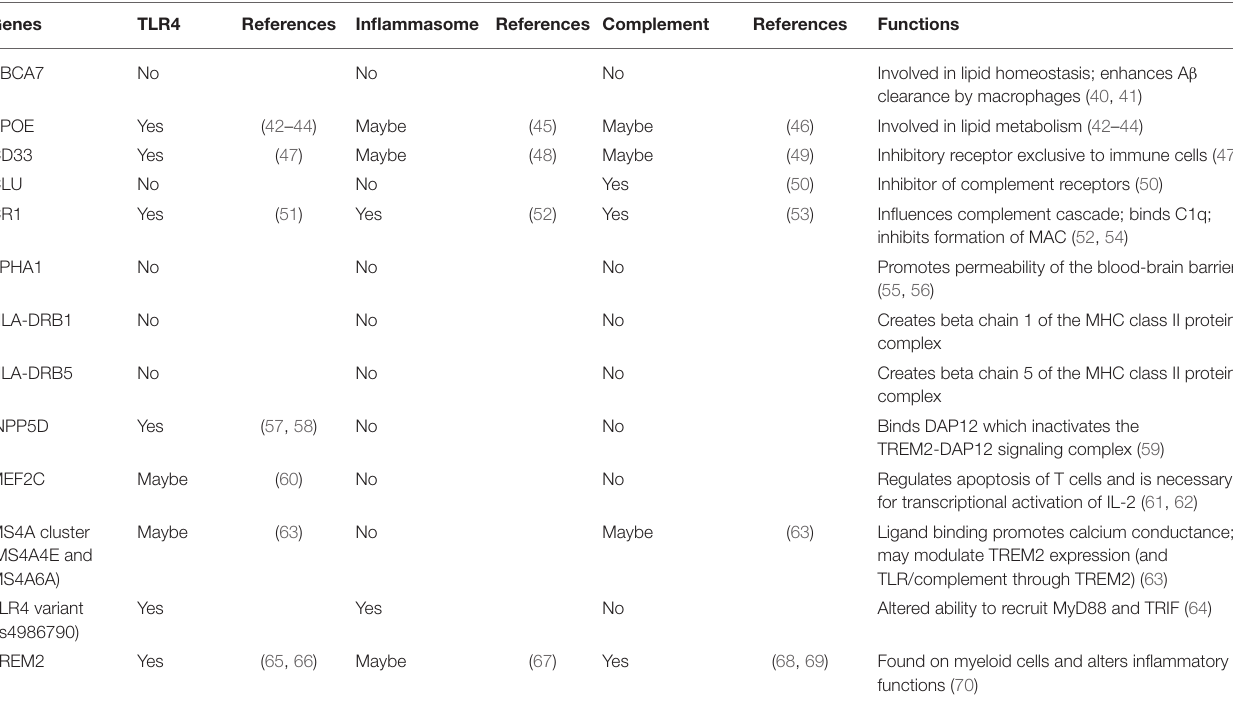
TABLE 1 | AD risk genes involved in inflammatory responses.